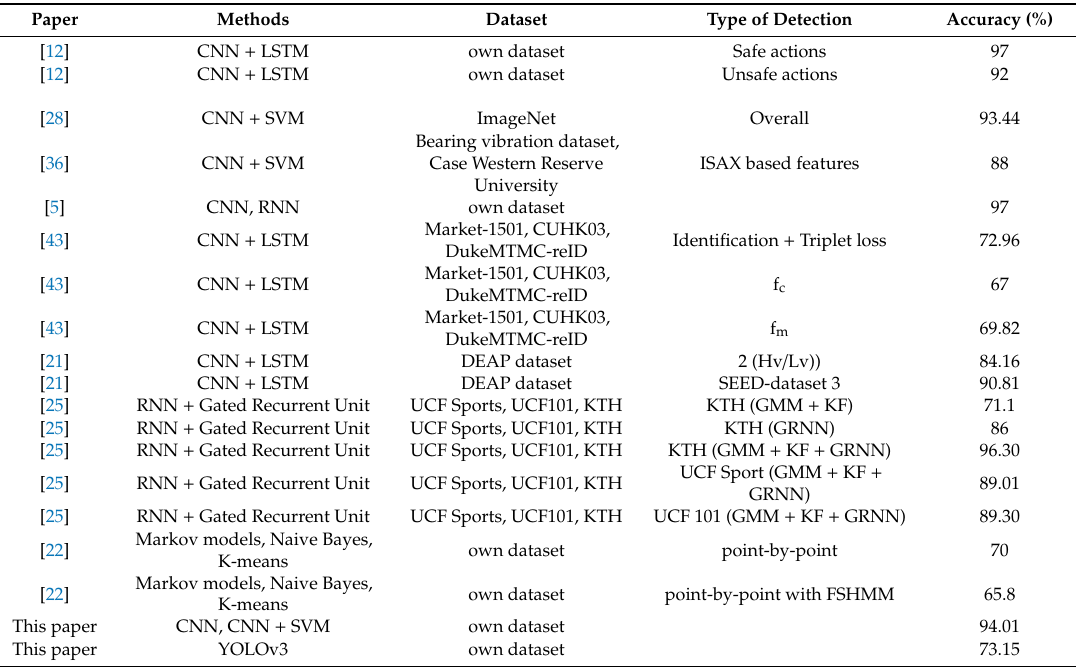
Table 9. The comparison results with existing, state-of-the-art